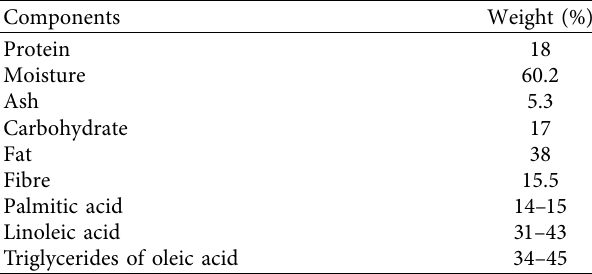
Table 3: Ghanaian Moringa oleifera oil components [6,